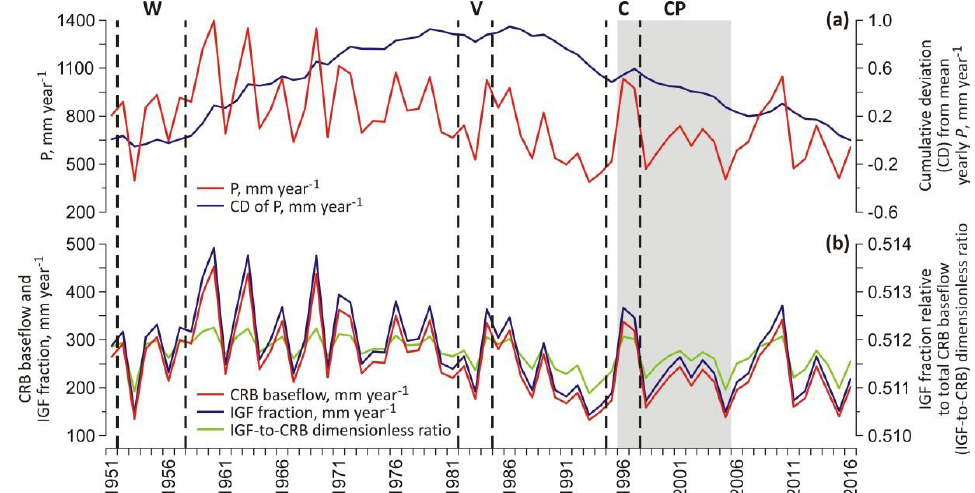
Figure 5. For the full period (1951–2016), ( a ) surface-weighted yearly P series in the area compiled from the Spanish National Weather Service (AEMET) grid version 1.0 and cumulative deviation (CD) from mean yearly P in mm year − 1 ; and ( b ) generated yearly baseflow series in the CRB and yearly surface-weighed IGF series from upstream GRW and SRW contributing areas in mm year − 1 , and IGF fraction relative to total CRB baseflow (IGF–CRB) dimensionless ratio. The control period (1996–2005) is grey shallowed (CP). Vertical dotted lines indicate selected time intervals for the SWAT model warm-up (W), calibration (C), and validation (V) phases.